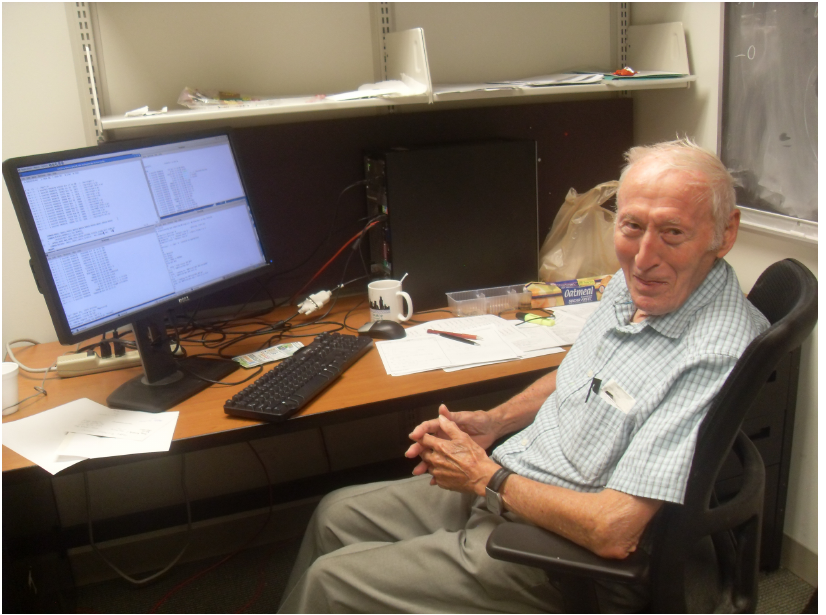
Figure 1. Werner Eissner at his desk as a Visiting Fellow (2014) of the Department of Astronomy, Ohio State University, Columbus, OH,